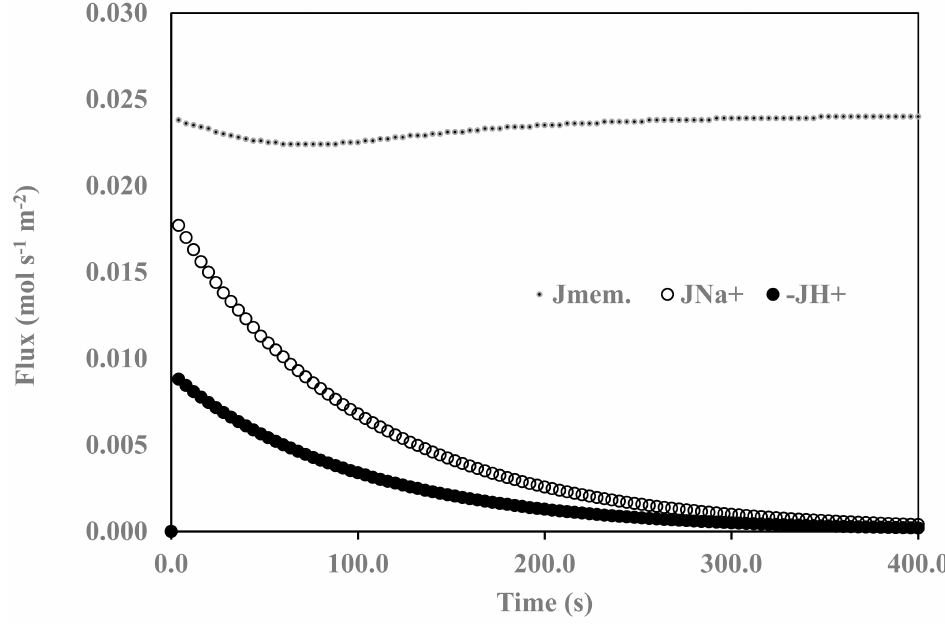
Figure 3. Comparison of simulated and limiting flows.